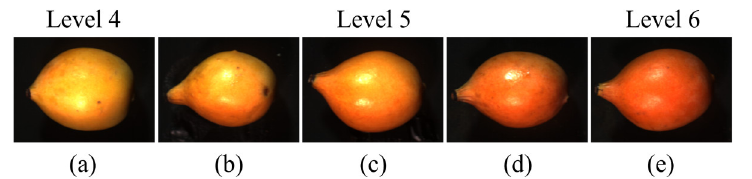
Figure 10. ( a , c , e ) Fruit samples of reference stages four, five and six. ( b ) Fruit samples with ripeness stage four assigned and classified as ripeness stage five by all models. ( d ) Fruit samples with ripe- ness stage six assigned and classified as ripeness stage five by all